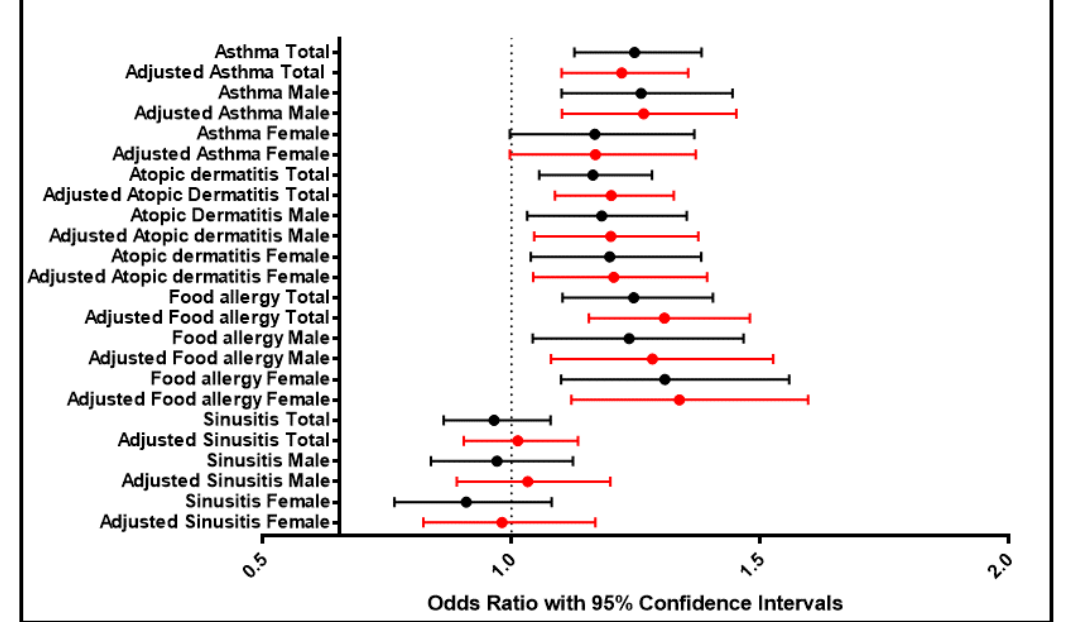
Figure 3. Confidence interval for odds ratio by allergic diseases. Odds ratios and adjusted odds ratios are displayed in black and red, respectively, p < 0.05.